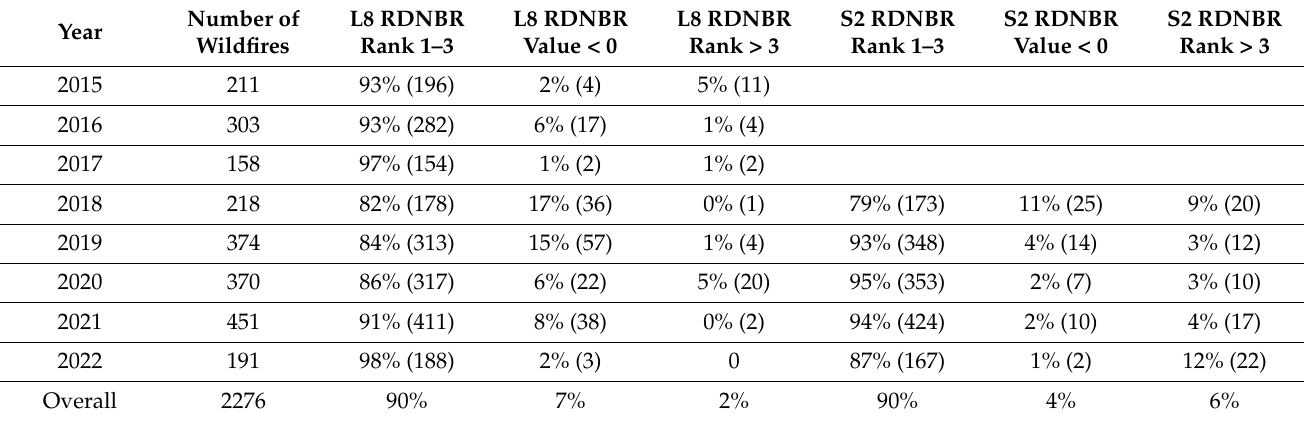
Figure 6. Absolute differences between incorrect wildfire dates in the original database (INPA) and the revised dates in the unified database, as a function of wildfire size (n = 77). Table 2. RDNBR rank index from Landsat 8 (L8) and Sentinel 2 (S2) time series for the wildfire season in Israel (end of April to November) from 2015 to 2022. The percentage was calculated according to the final (merged) number of INPA total wildfires each year. The number in parentheses indicates the total number of wildfires that had a high RDNBR value expressed in rank value between one to three, a rank value larger than three, and a negative index value (which indicates regrowth or unburned